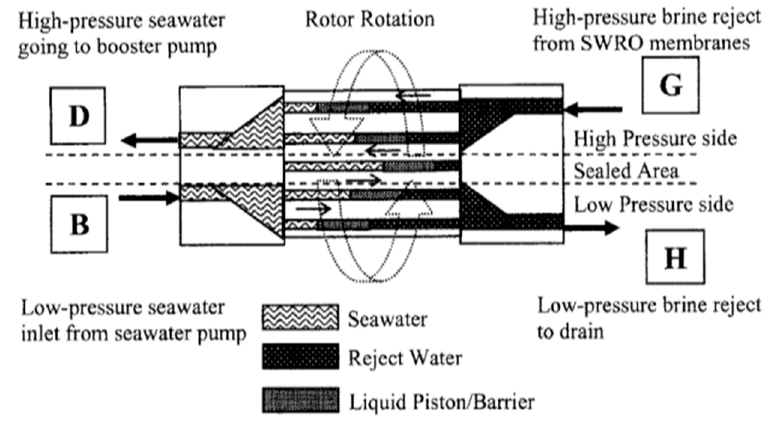
Figure 9. PX flow schematic [45].